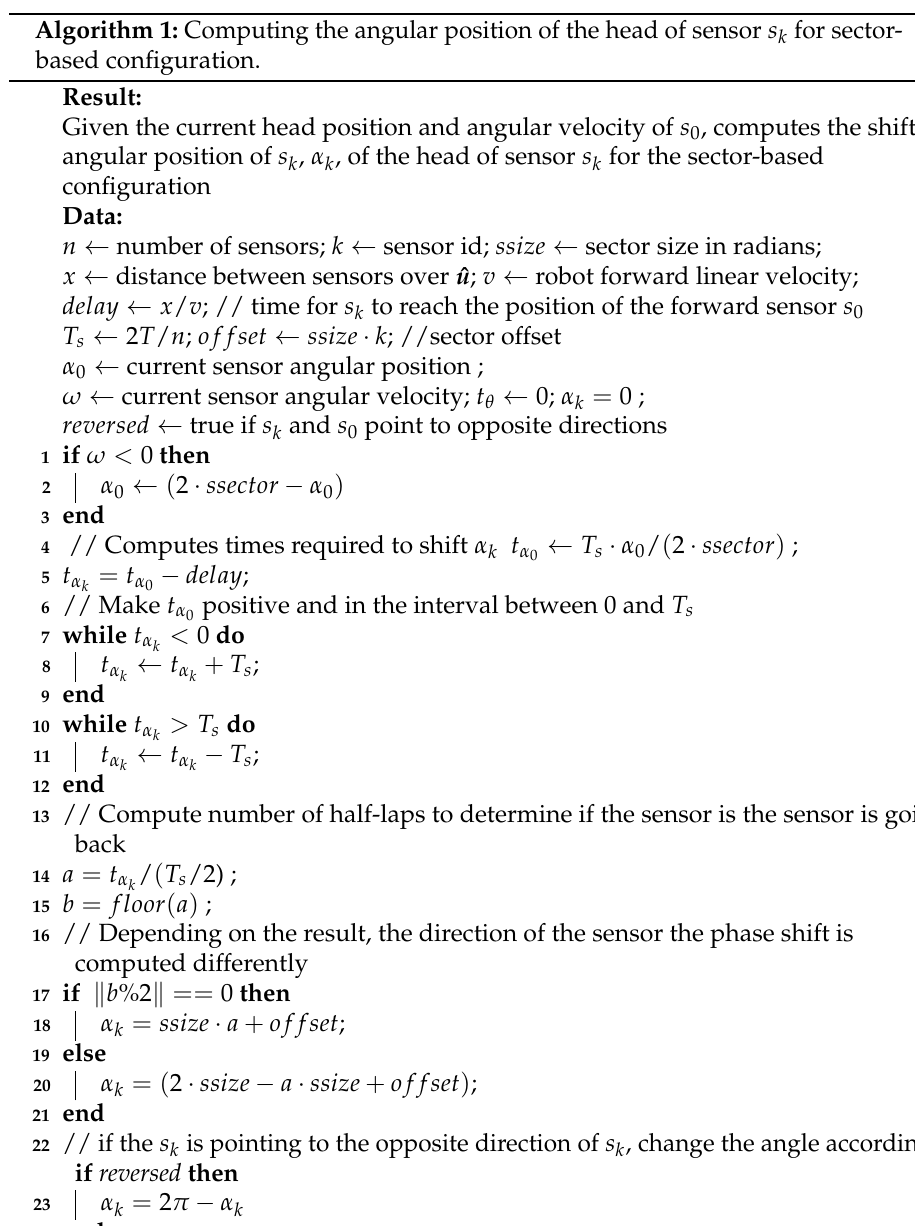
Algorithm 1: Computing the angular position of the head of sensor s k for sector- based